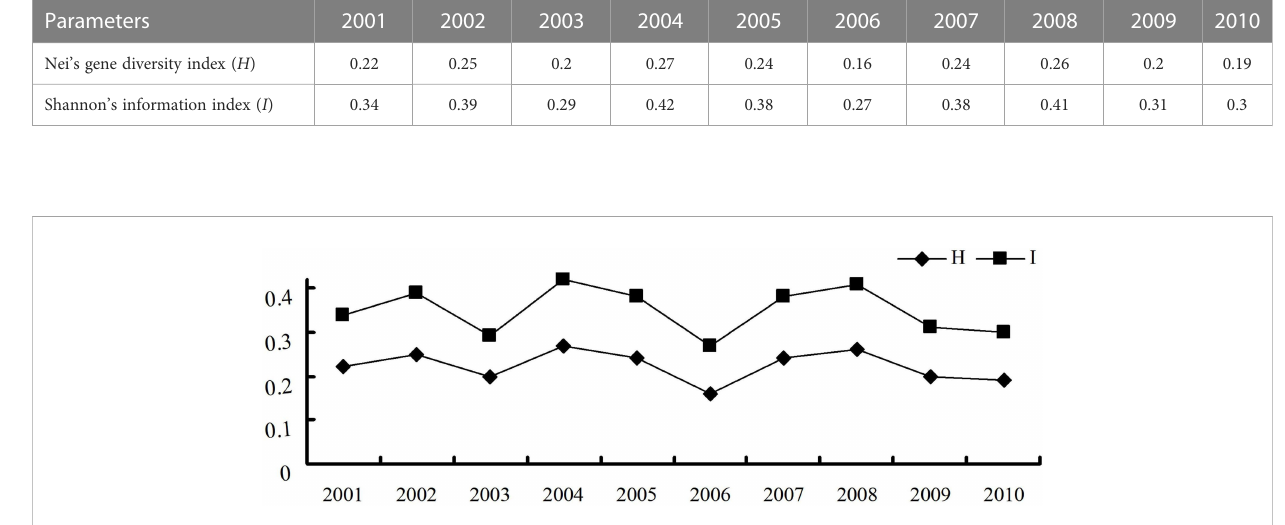
TABLE 3 Numbers of alleles, polymorphic alleles, and percentage of polymorphism of 14 pairs of EST-SSR primers.